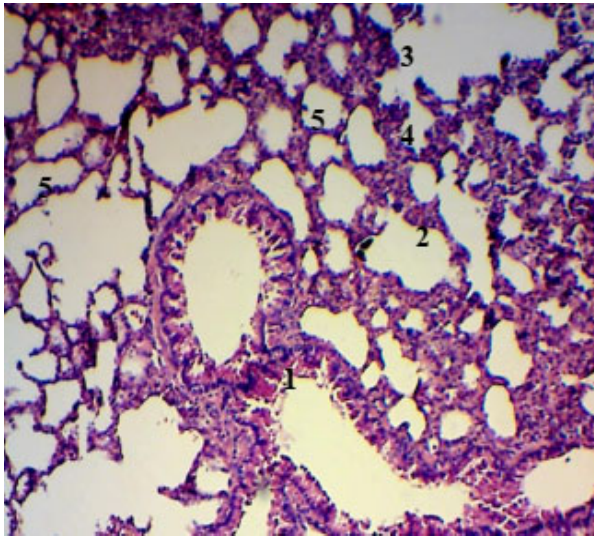
Fig. 5. Fragment of the histological structure of the lungs Fig. 6. A fragment of the histological structure of the of a mature rabbit: 1 – lumen of the middle bronchus; 2 – respiratory parenchyma of the lungs of a mature rabbit: islet of cartilaginous tissue; 3 – alveoli; Hematoxylin and 1 – bronchioles; 2 – alveolar sacs; 3 – alveolar ducts; 4 – eosin. X. 120 alveoli; 5 – alveolar septa; Hematoxylin and eosin. X. 120 The cartilaginous tissue is almost absent in bronchi with medium caliber and it is found only in the form of individual cartilaginous islands, which are small (Fig. 5). Their mucous membrane is covered with a single layer of multilayered respiratory epithelium. Cartilage and glands are absent in the bronchi of small caliber. Their mucous membrane is lined with a single layer of ciliated epithelium. They branch into terminal